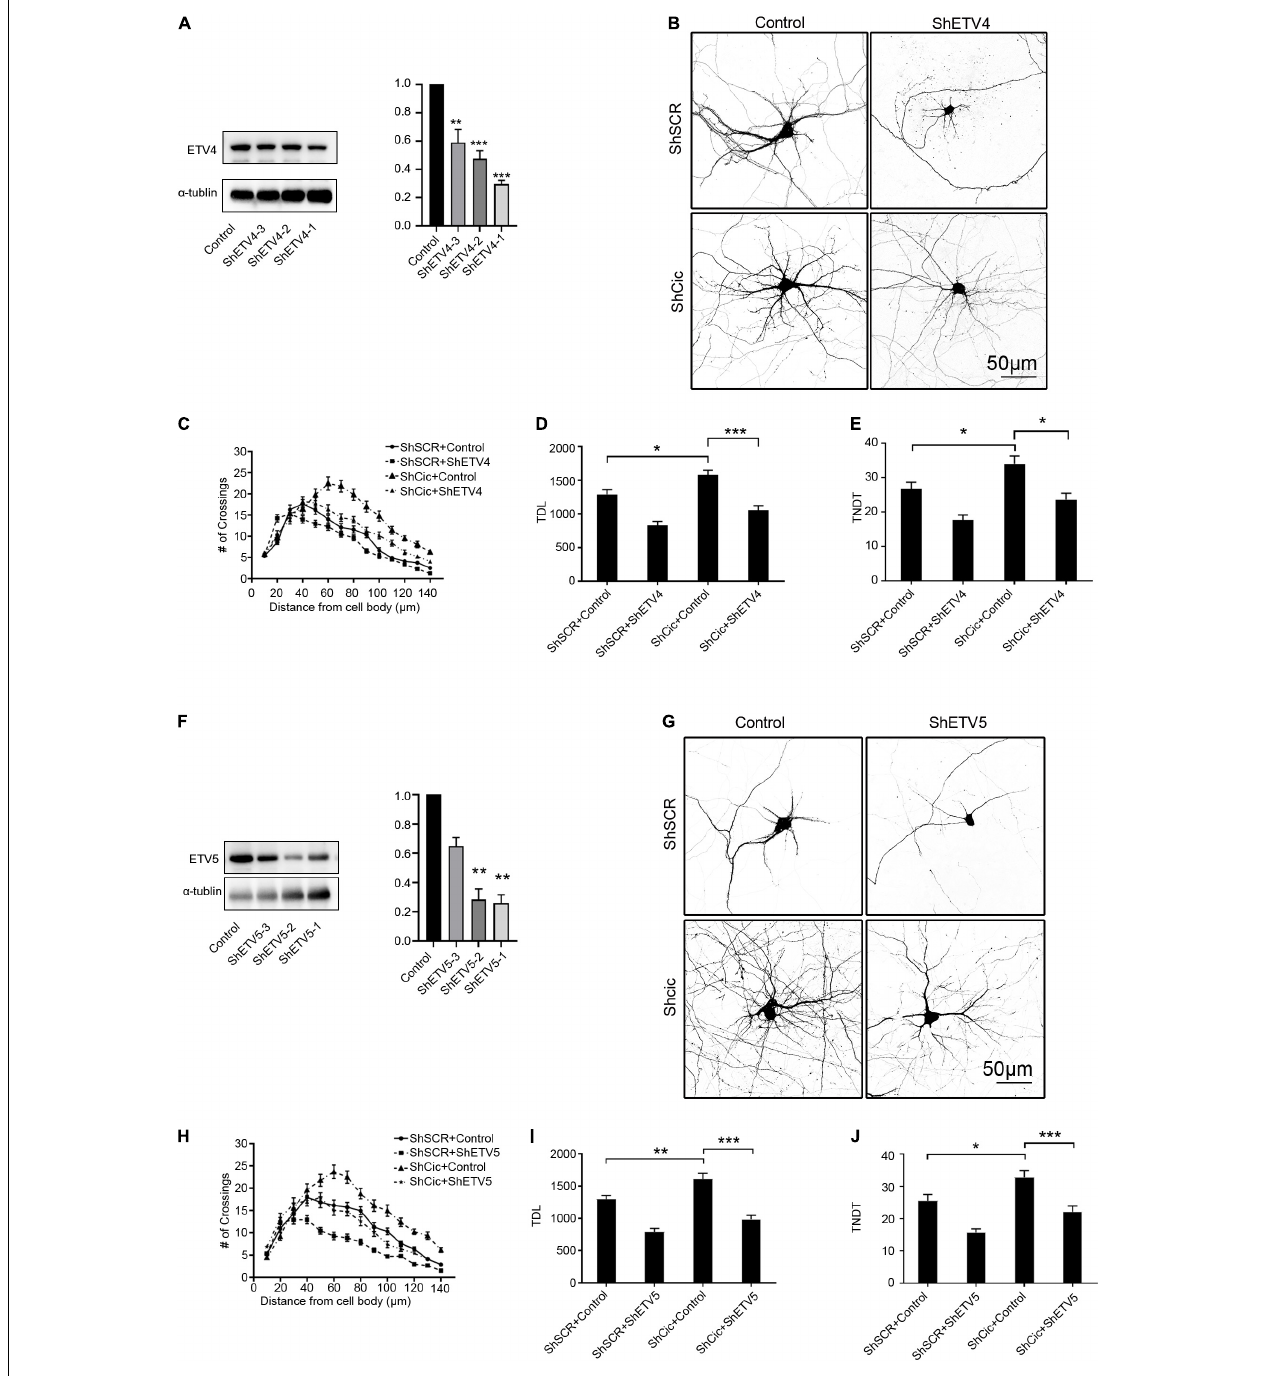
FIGURE 5 | Cic silencing induced promotion of dendritic spine growth was suppressed by Ets knockdown. (A) The Etv4 protein expression level in HT22 cells after ShEtv4 or scramble plasmid transfection was detected by western blot. The right panel shows the quantification of the WB. (B) Hippocampal neurons cultured in vitro were cotransfected on DIV 7 for 7 days with control or ShEtv4 and scramble ShSCR or ShCic. (C–E) Neuronal morphology was visualized by cotransfection with enhanced green fluorescent protein. Sholl analysis (ShSCR/Control, n = 48; ShSCR/ShEtv4, n = 48; ShCic/Control, n = 48; ShCic/ShEtv4, n = 48) (C) , TDL ( n as in C ) (D) , and TNDT ( n as in C ) (E) of neurons after transfection with the indicated plasmids. (F) The Etv5 protein expression level in HT22 cells after ShEtv5 or empty vector transfection was detected by western blot. The right panel shows the quantification of the WB. (G–J) Representative images of hippocampal neurons transfected on DIV 7 for 7 days with control or ShEtv5 and scramble ShSCR or ShCic. Neuronal morphology was visualized by cotransfection of enhanced green fluorescent protein. Sholl analysis (ShSCR/Control, n = 48; ShSCR/ShEtv5, n = 48; ShCic/Control, n = 48; ShCic/ShEtv5, n = 48) (H) , TDL ( n as in H ) (I) , and TNDT ( n as in H ) (J) of neurons after transfection with the indicated plasmids. The error bars indicate the SE. *** p < 0.001; ** p < 0.01; * p < 0.05.